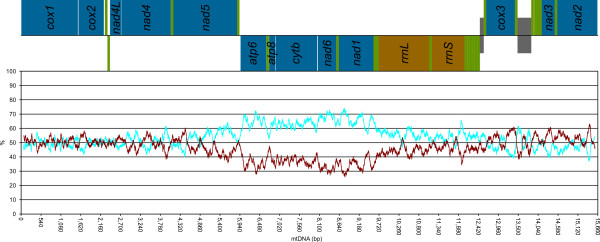
A-C and G-T content along the mitochondrial genome of S. velum. A-C (pale blue) and G-T (dark red) contents are computed on a sliding window of size 151 bp. A linear sketch of the complete genome as annotated in Figure 1 is depicted above the plot: blue, PCGs; green, tRNAs; brown, rRNAs; gray, URs >100 bp; genes on the “ + ” strand are above the black line and genes on the “-” strand are below it.